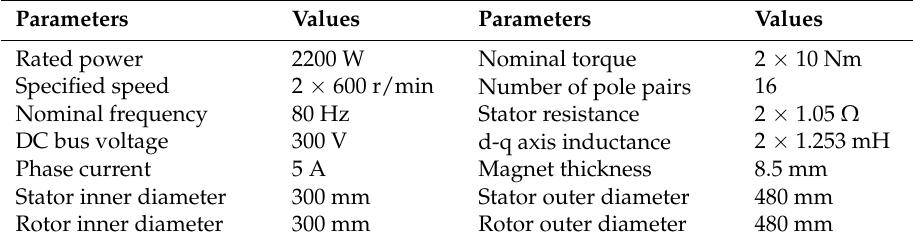
Table 1. Nominal parameters of the permanent magnet synchronous motor (PMSM) with dual-rotating rotors.